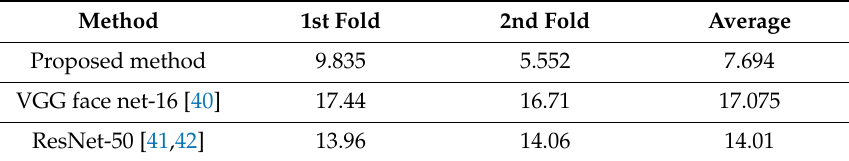
Table 8. Comparison of EER for the results of the proposed method and previous face recognition methods (unit: %).